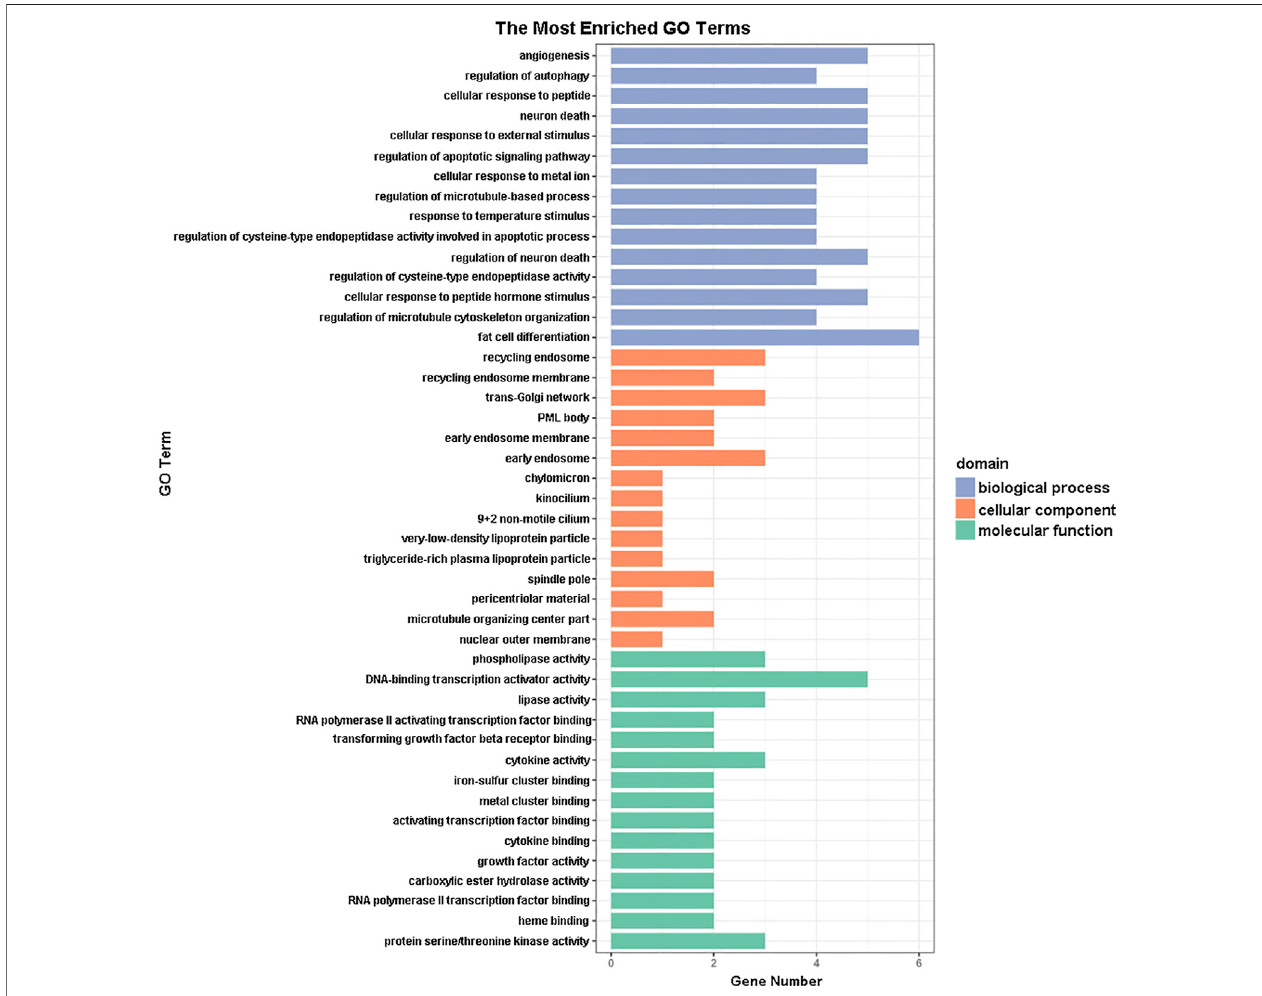
FIGURE 3 | Gene ontology (GO) enrichment analysis results. The 15 most enriched GO terms in each of the three GO domains (molecular function, biological process, and cellular component) for the differentially expressed genes.